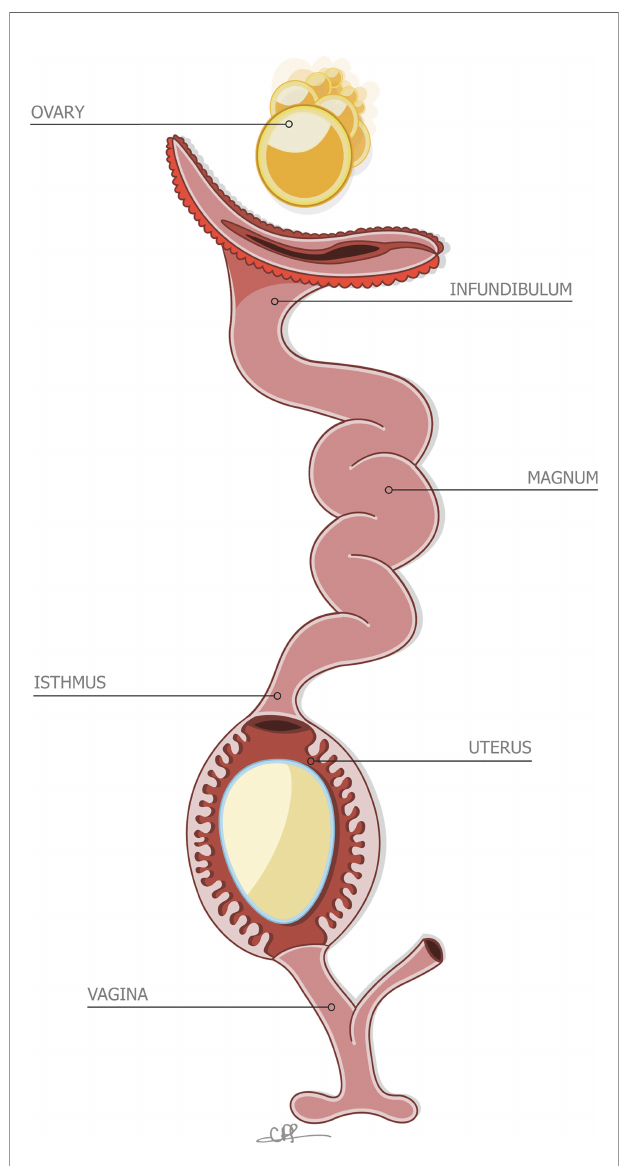
FIGURE 2 | Stylized depiction of the reproductive system of the hen, containing an incomplete egg in the uterus. Reprinted from Front Bioscience., Vol. 17, Issue 1, Hincke et al., The eggshell: structure, composition and mineralization, 1266-1280, 2012, with permission from